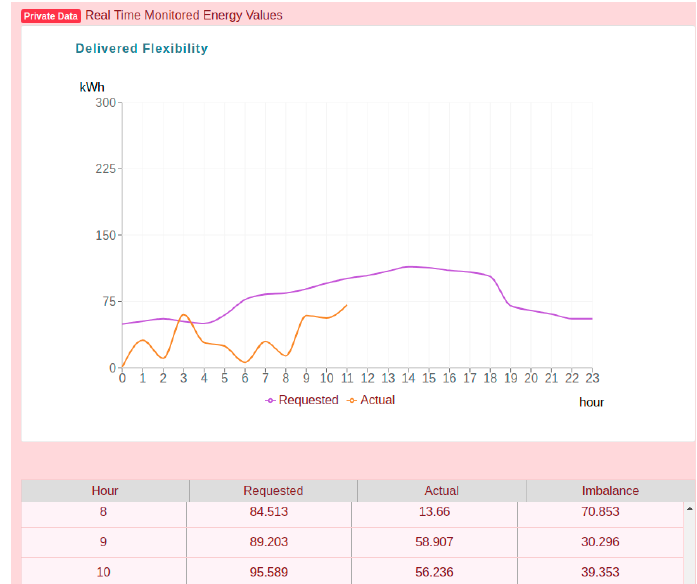
Figure 15. Prosumer private energy data information showing the stop of its participation in the DR program.